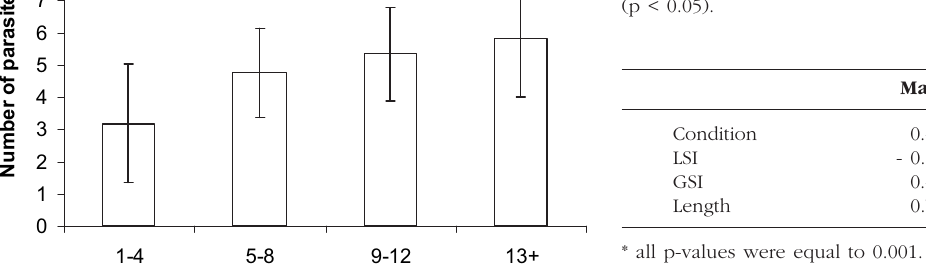
Fig. 3. – Mean number and length (mm) (± 1 SD) of Echinorhyn- chus gadi in the foregut, midgut and hindgut of shorthorn sculpin from Peterhead Inlet and the Sylvia Grinnell River estuary, Nunavut. a = statistically significant differences between foregut, midgut and hindgut (p < 0.05); b = no significant differences between fore- gut and midgut, significant differences between foregut and hindgut (p > 0.05); c = significant differences between midgut and hindgut (p < 0.05).